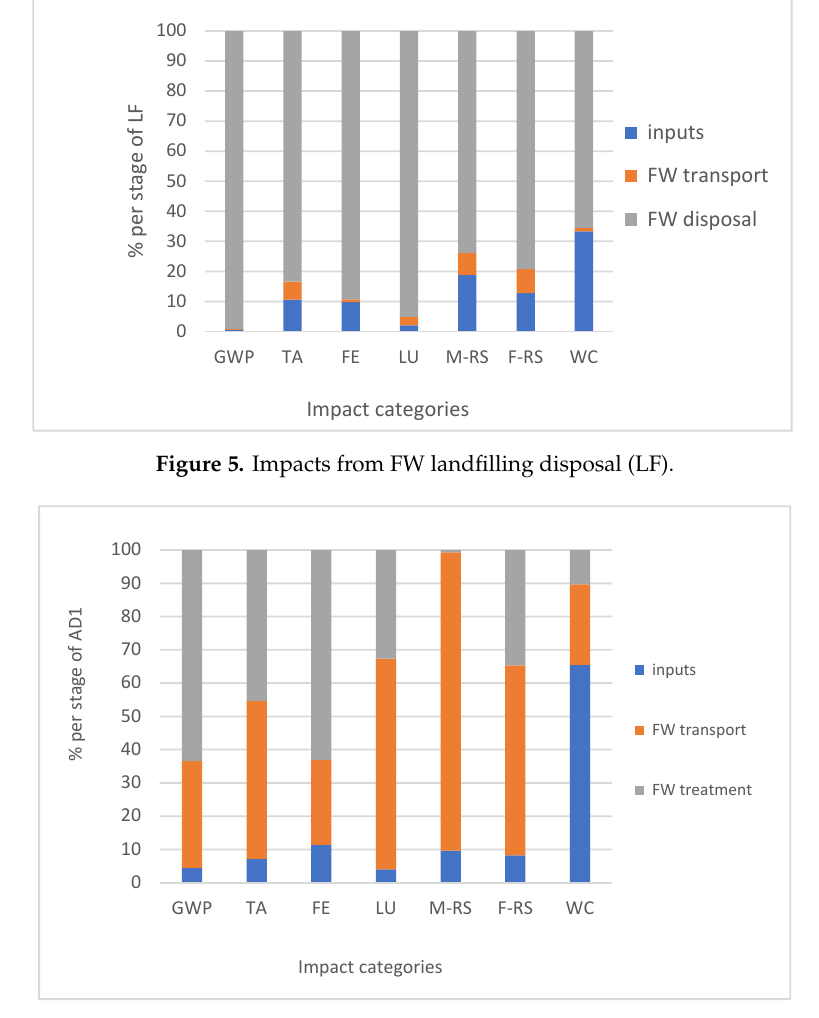
Figure 6. Impacts from FW Anaerobic Digestion in a centralized scenario (AD1).